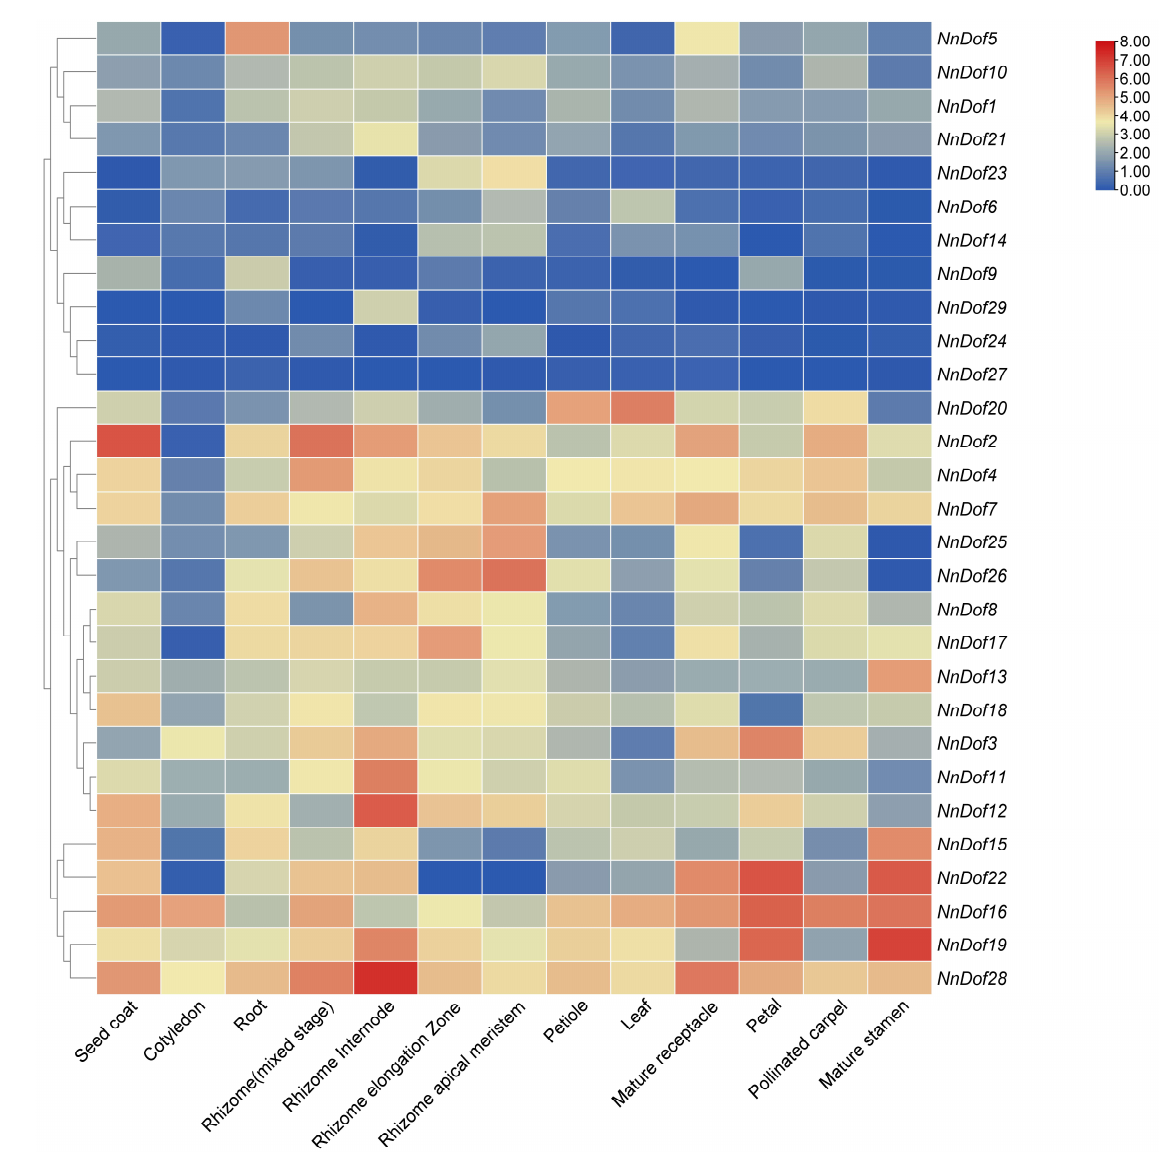
Figure 8. Expression pattern of NnDofs in different tissues of lotus. The expression pattern was generated based on FPKM plus 1 after log2 transformation and analyzed by heatmap hierarchi- cal